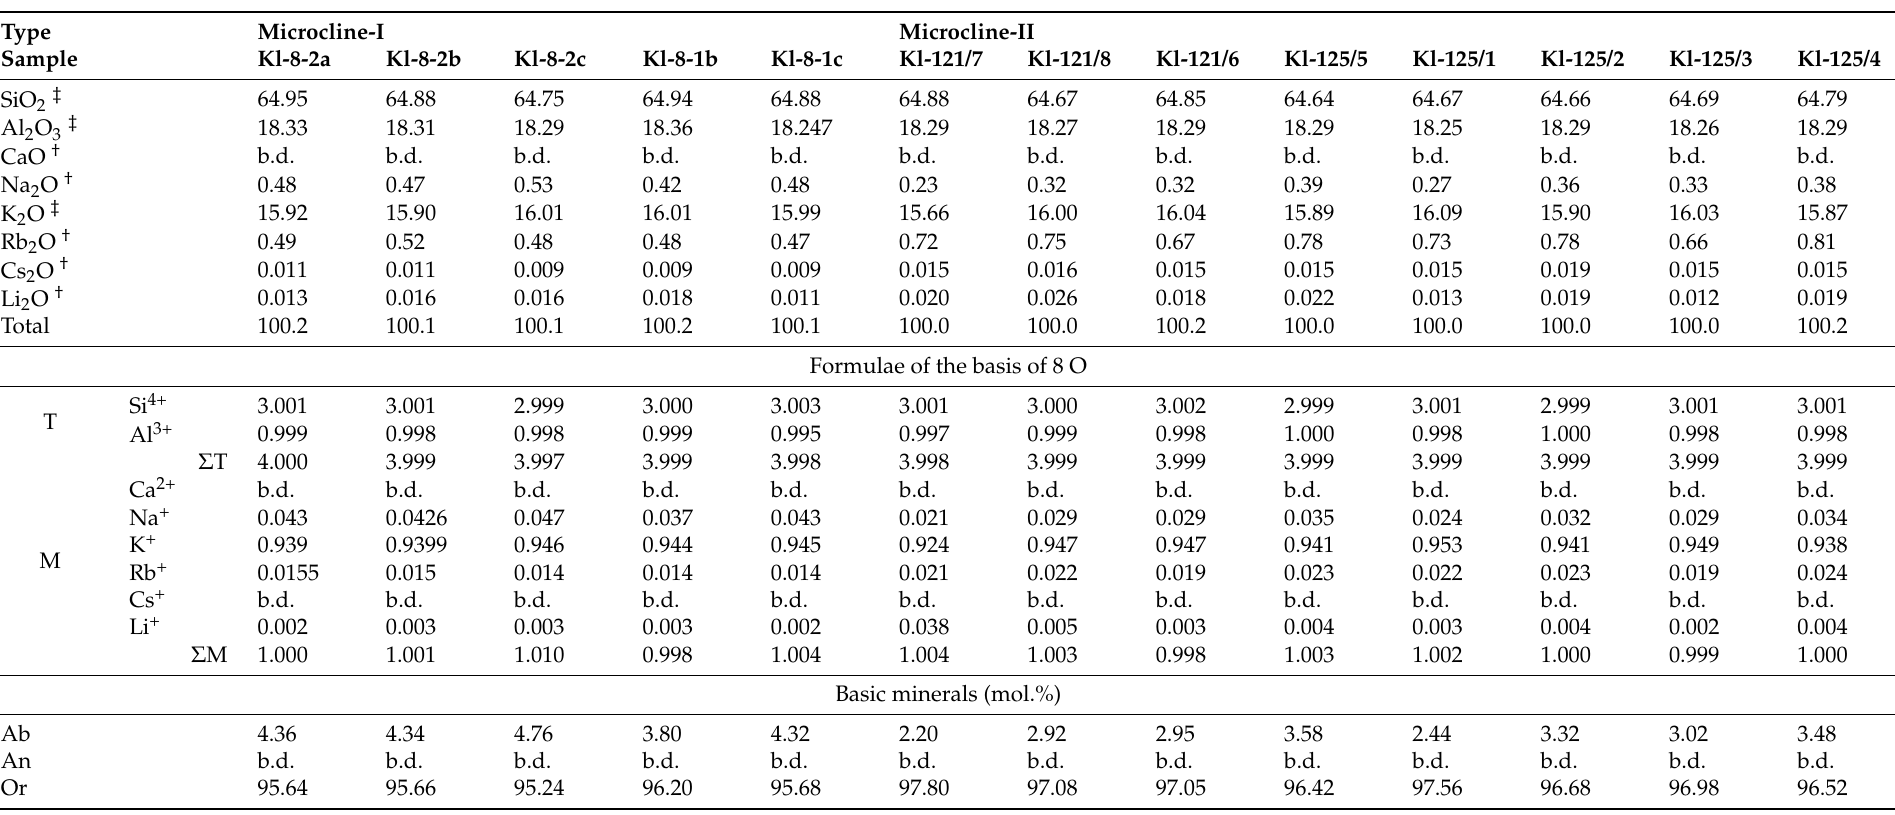
Table 1. Representative chemical composition (wt.%) and mineral formulae (apfu) of K-feldspar from the albite-spodumene pegmatites determined by electron microprobe